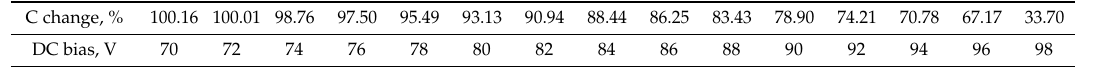
Table 4. Drop range of capacitance with DC bias for KZM100-MOD-Y.